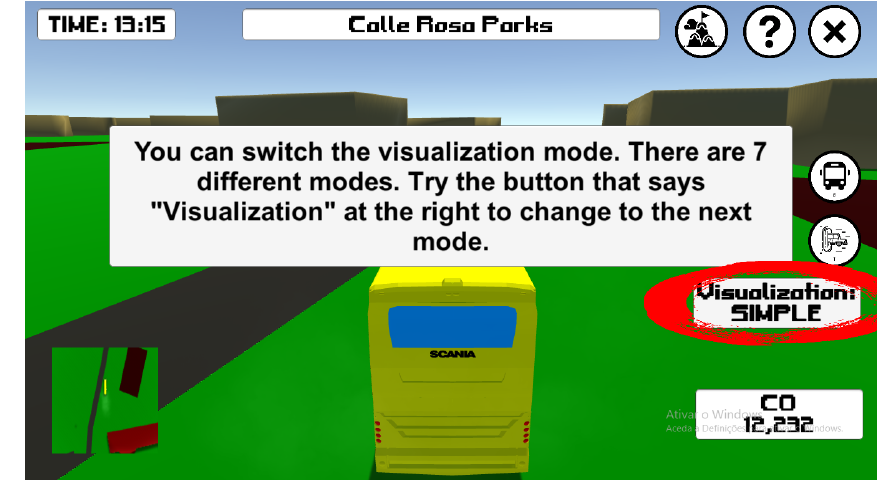
Figure 7. A snapshot of CityOnStates’s interactive